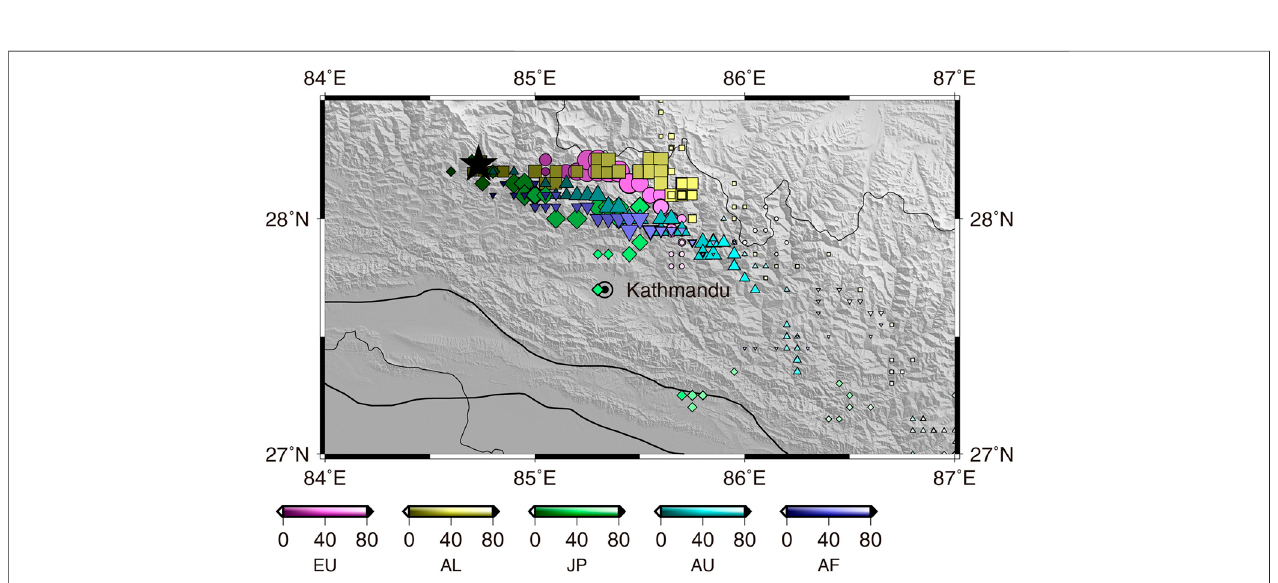
FIGURE 2 | Rupture front of the 2005 Nepal – Gorkha earthquake imaged by classical BP using EU, Al, JP, AU, and AF. Color shades of the icons represent the duration. The units of the color scale are second. The two fault lines from top to bottom are the Main Boundary Thrust (MBT) and the Main Front Thrust (MFT).